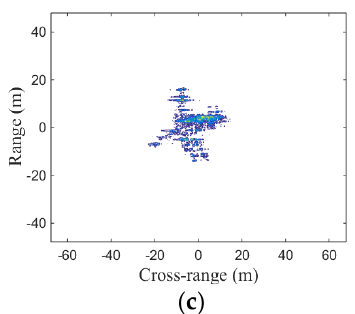
Figure 7. Coherent fusion imaging results of real-data: ( a ) imaging result of real-data without LTFE; ( b ) imaging result of real-data with LTFE; ( c ) imaging result of real-data after calibrating LTFE. Table 7. Image entropy of Figure 7. Figure Image Entropy